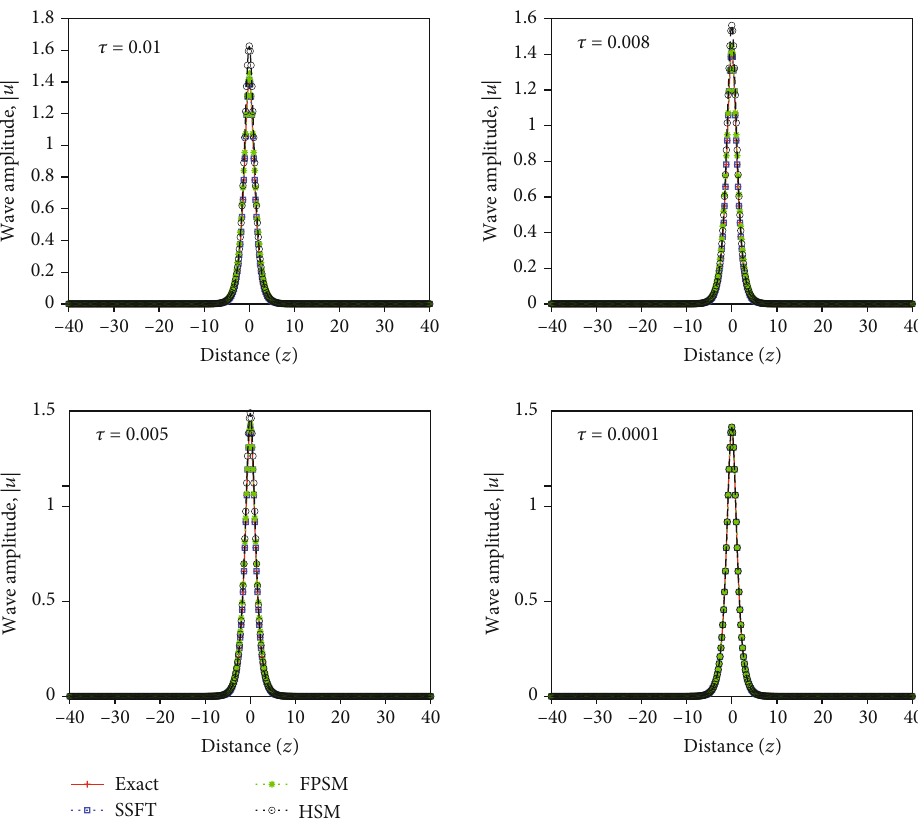
Figure 4: A comparison of the split-step Fourier transform (SSFT) and the Fourier pseudospectral method (FPSM), the Hopscotch method (HSM), and the exact solution at h = 0 : 2 and t = 20 over a space domain z from -40 to 40, whereas using di ff erent values τ . Table 1: A comparison among the sum of squares error (SSE) of the split-step Fourier transform (SSFT), the Fourier pseudospectral method (FPSM), and the Hopscotch scheme (HSM), computed for di ff erent time values t from 35 to 105 : When h = 0 : 2 and τ = 0 : 001 . Time, t